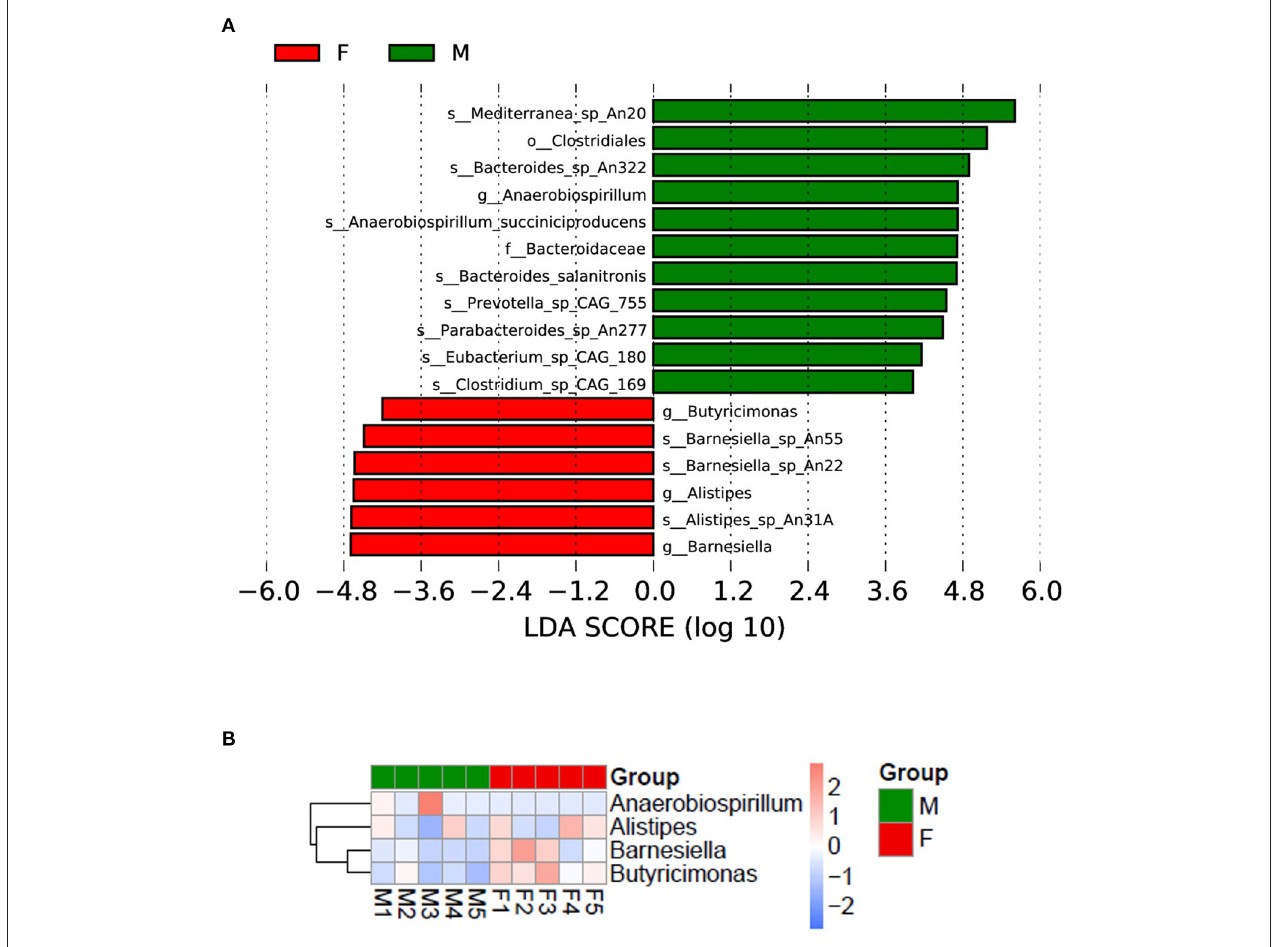
FIGURE 3 | (A) Different bacterial species in female (F) and male (M) Japanese quail ( Coturnix japonica ); (B) different species clustered in four